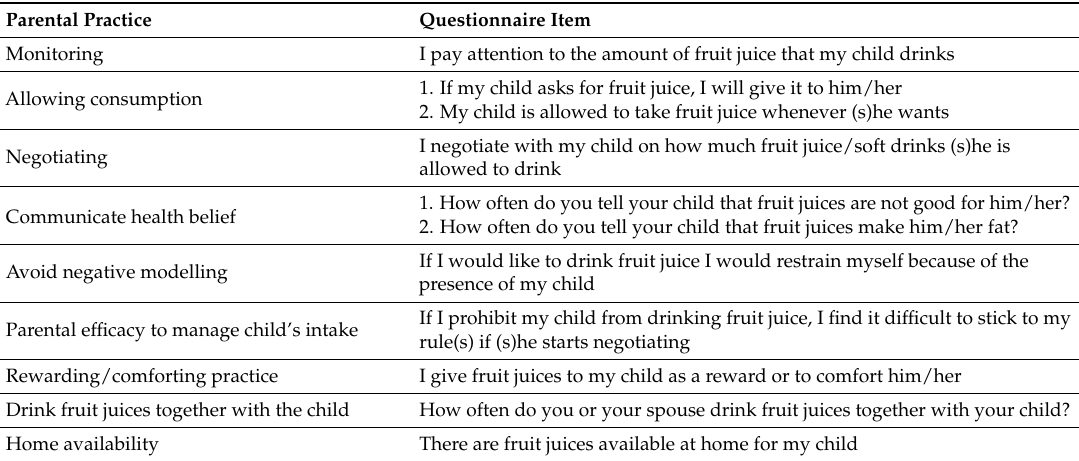
Table A1. Parenting practices on sugary beverages consumption assessed in the EPHE